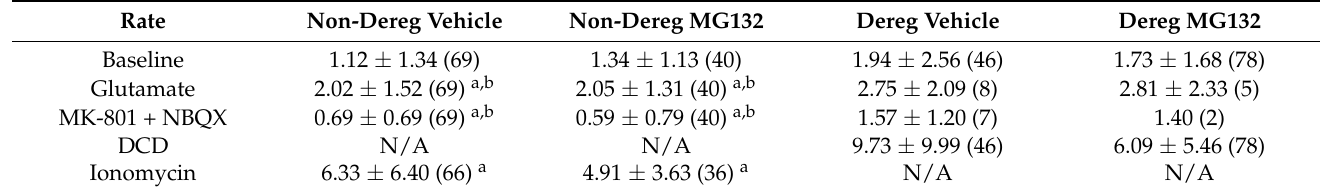
Table 3. cA-TAT proteolysis rates (arbitrary units/min) in neurons that did (Dereg) or did not (Non- dereg) undergo Ca 2+ deregulation within two hours of glutamate addition when vehicle (0.2% DMSO) or the proteasome inhibitor MG132 (20 µ M) was present. Values are given as means ± standard deviations, with the number of cells in parenthesis. Significance was evaluated by mixed-effects model ANOVA using